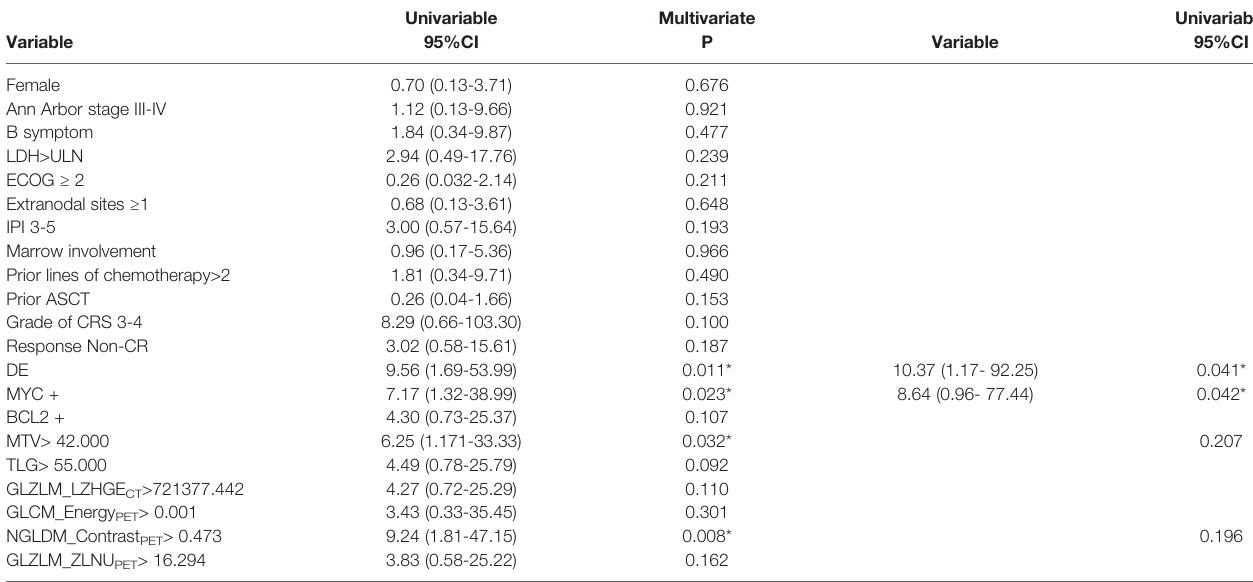
TABLE 4 | Univariable and multivariate analyses of predictive factors for